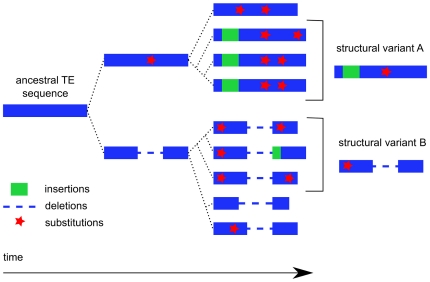
Schematic diagram of the dynamics of a TE family with two structural variants.